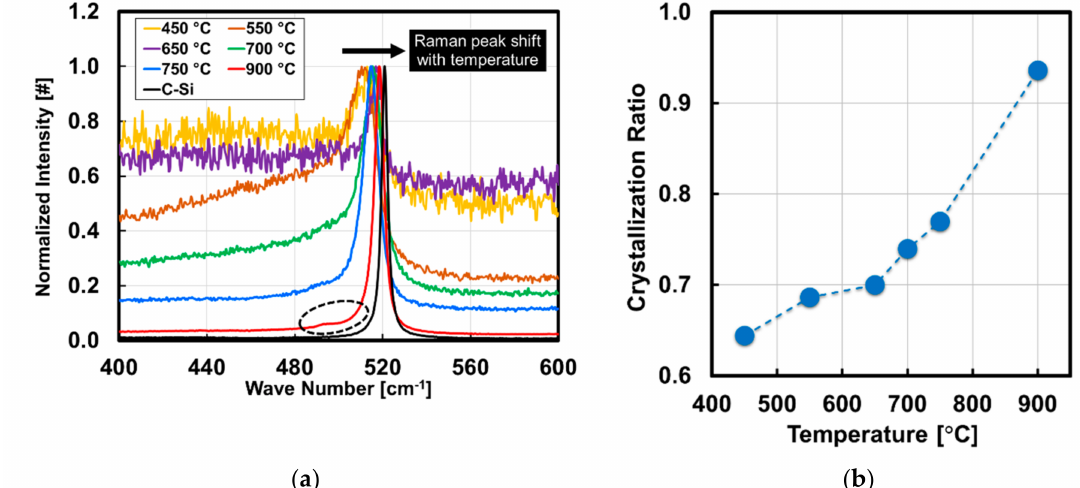
Figure 4. ( a ) Normalized Raman spectra of the CuIC micro-Si films fabricated on a glass substrate after thermal annealing at various temperatures, ( b ) The crystalized volume fraction of the fabricated CuIC micro-Si films vs. annealing